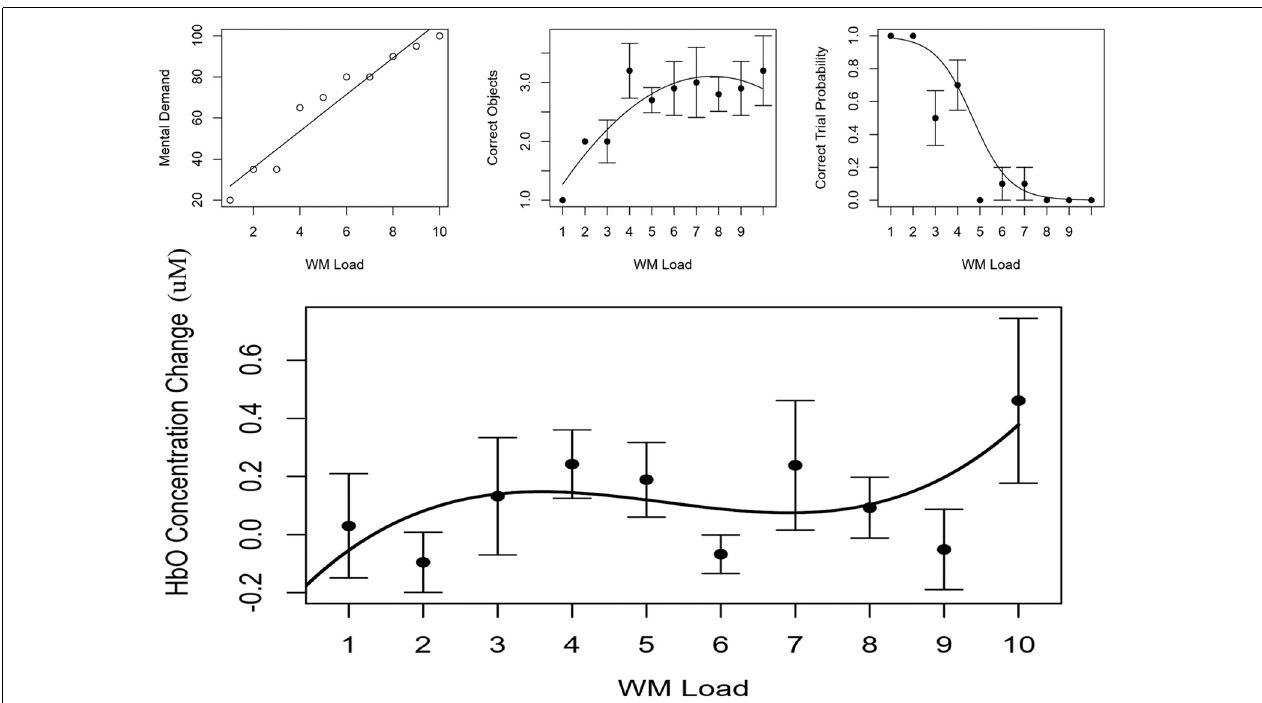
FIGURE 7 | Top Left is participants reported mental demand, top middle is model of correct number of objects reported, top right is probability of perfect accuracy. (Bottom) Relative concentration changes in oxygenated hemoglobin (HbO) as a function of working memory load in the LDLPFC (Channel 4). Annotated from the behavioral models are the estimates of working memory capacity (WMC and PSE) as well as bounding estimates of optimal workload ( d 75 to d 25 ). HbO estimates of WMC (INF) and bounding estimates of optimal load are also annotated (ST1, ST2).